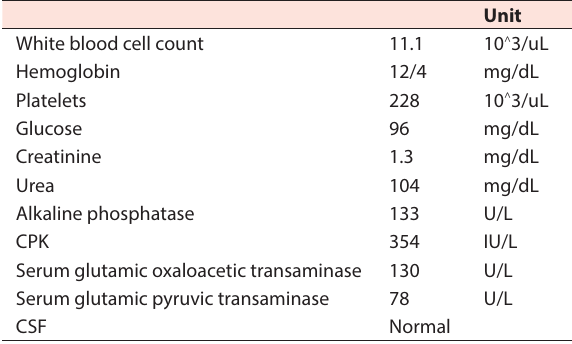
Table 1. The results of the initial